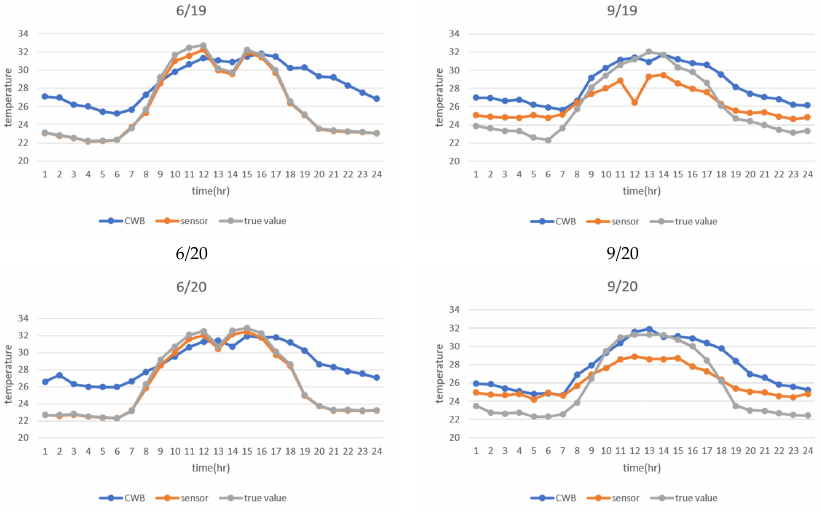
Figure 10. Line chart of the predicted and true values.